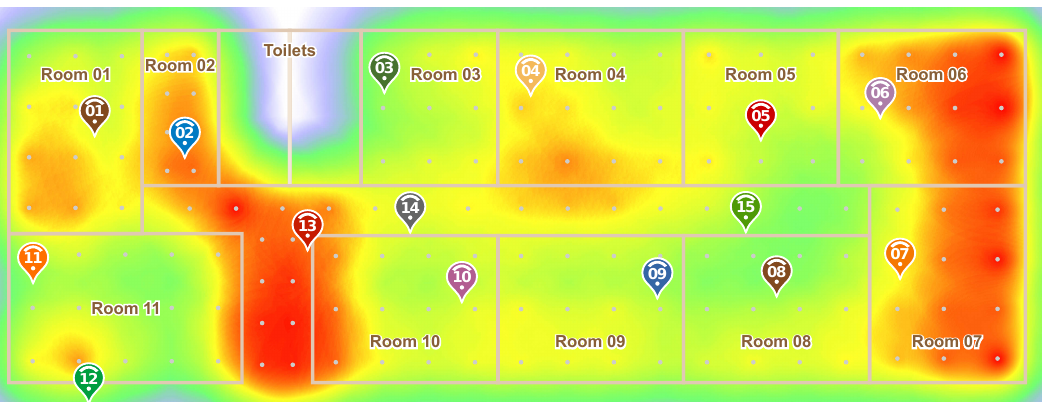
Figure 12. Heatmap of the average errors for each test point in the